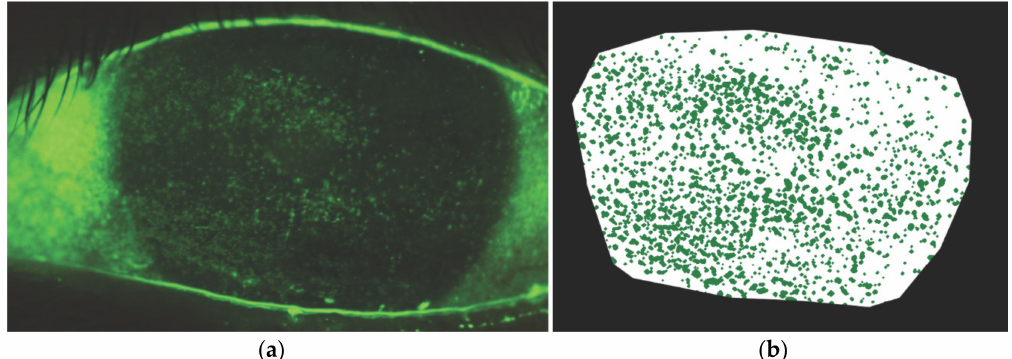
Figure A1. ( a ) CFS image as uploaded by the trial sites to the reading center; ( b ) CFS image after manually segmenting the cornea and application of a threshold-based segmentation of the CFS-positive lesions. The final readout is the percentage of total green pixels divided by the total pixels of the cornea area.